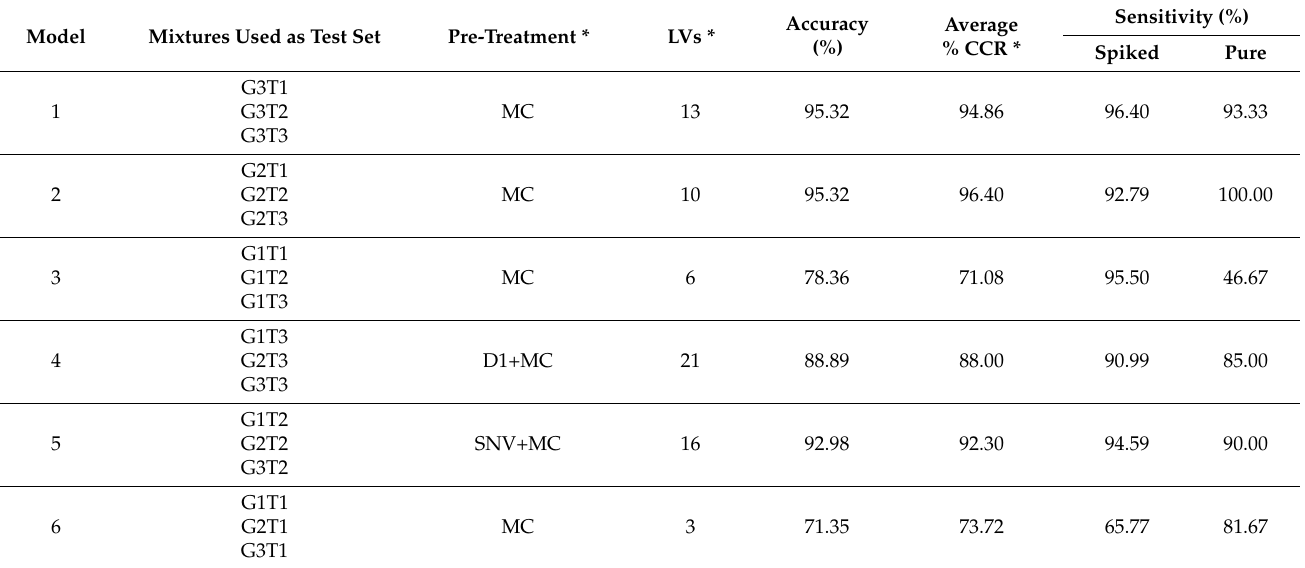
Table 1. Classification results of the six calculated PLS-DA models on their respective test set samples.